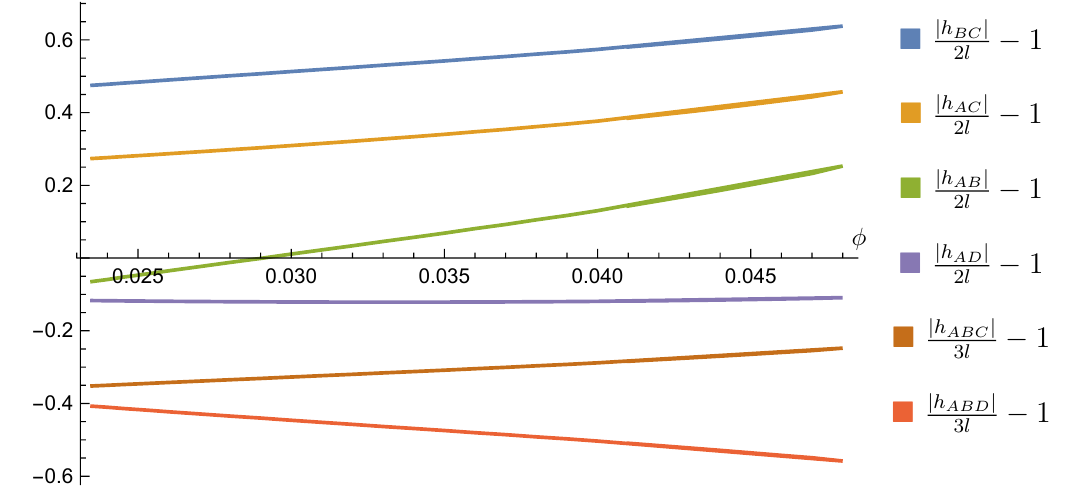
Figure 5 . In this case the two phases di(cid:11)er only in moduli and have the same Schottky domain.